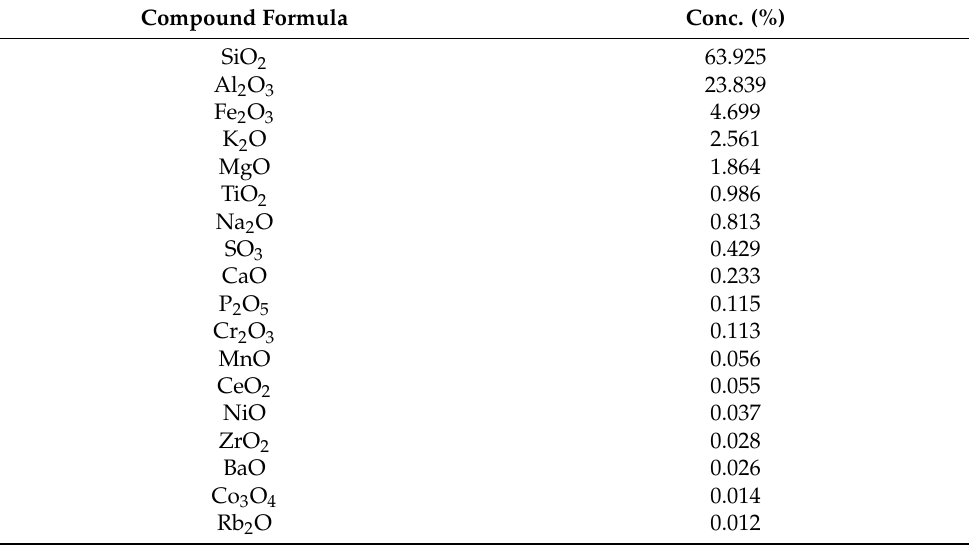
Table 2. Identified oxide composition of calcinated coal gangue from the Wieczorek mine by the XRF method.